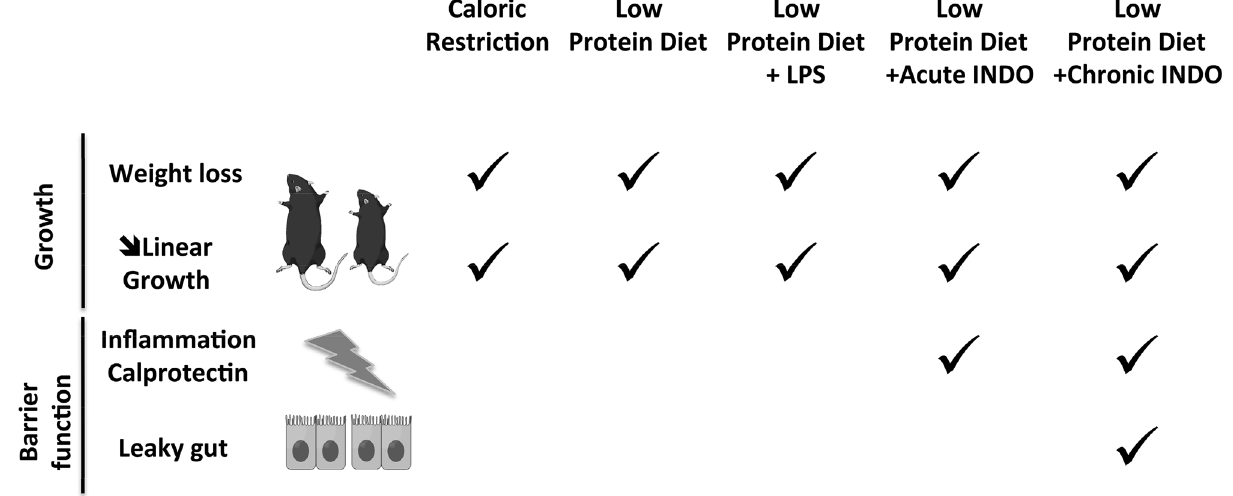
Figure 7. Undernutrition leads to growth failure and is often associated to environmental enteric dysfunction (EED). We aimed to develop a preclinical model of undernourished model with environmental enteropathy features such high intestinal inflammation and intestinal permeability. To induce undernutrition with EED, post-weaning C57BL/6 mice were fed with malnourished diet alone or combined with a gastrointestinal insult trigger. Growth was assessed by body weight and tail length. Intestinal permeability and inflammation were used as enteropathic markers. CR and LP for 3 weeks induced stunting and wasting but had no intestinal impact. We therefore decided to combine LP diet to a gastrointestinal insult trigger by liposaccharides (LPS) or indomethacin. LPS did not significantly impact small intestine while indomethacin increased fecal calprotectin production. To accentuate the effects, we investigated the effects of repeated gavages of indomethacin in addition to LP diet and mice exhibited stunting and wasting with intestinal hyperpermeability and gut inflammation.